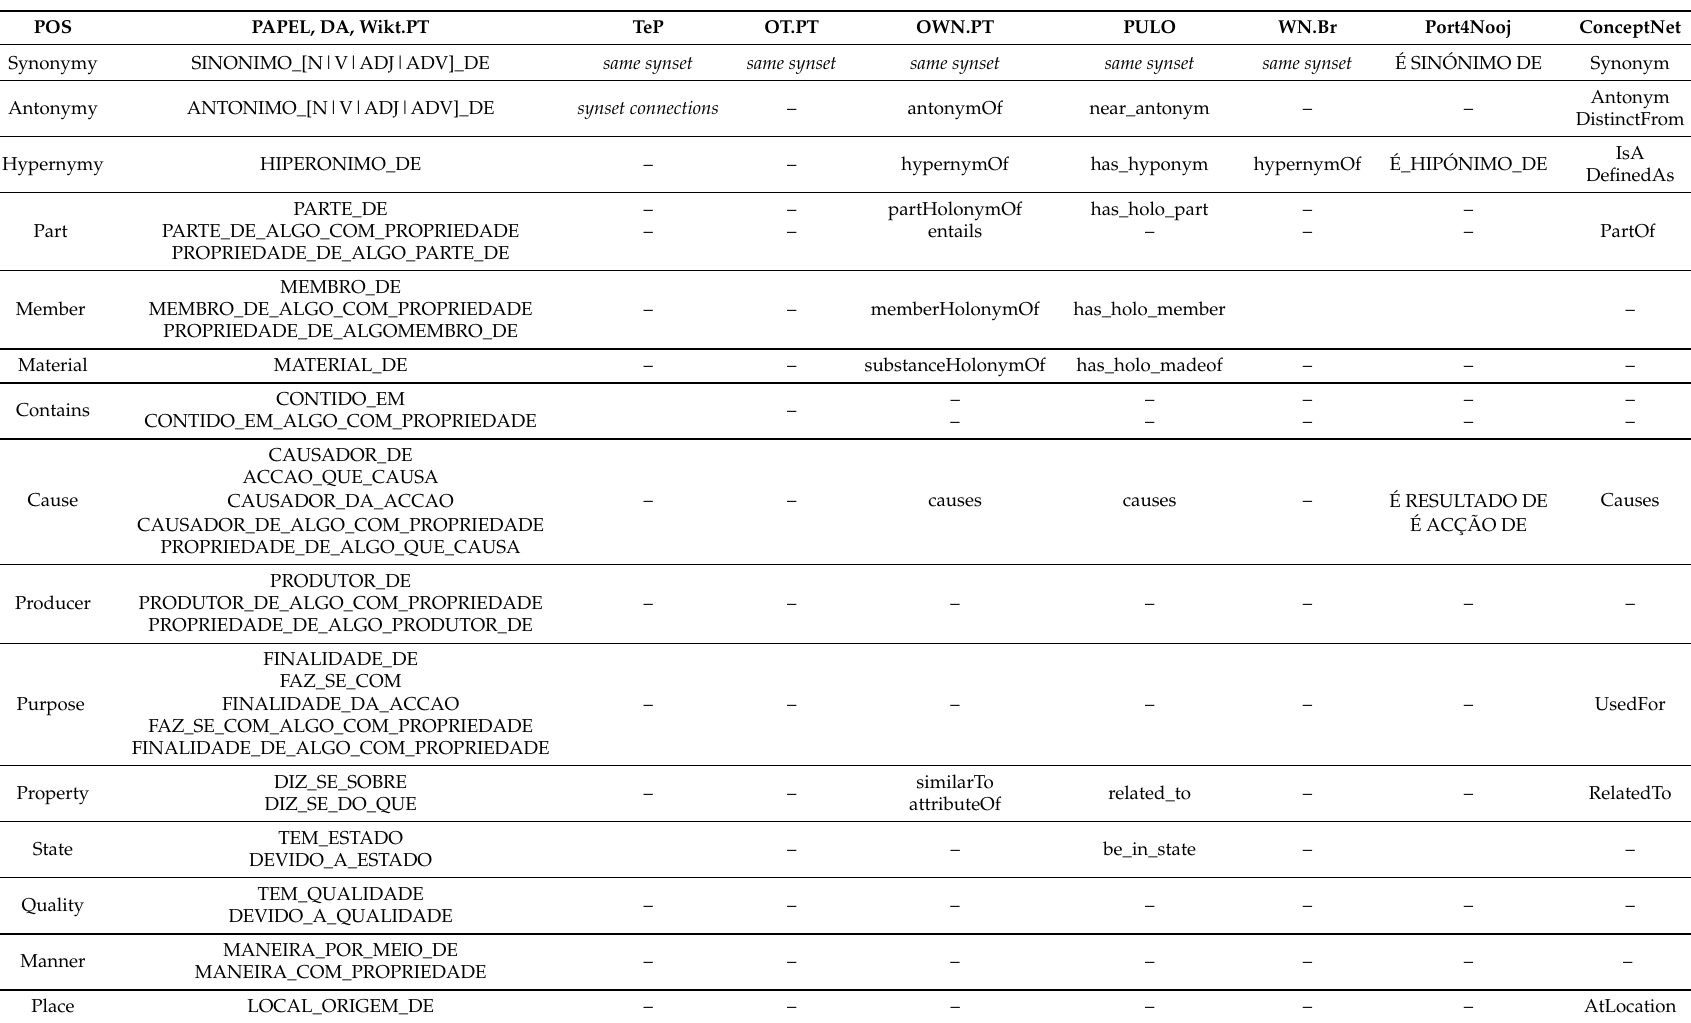
Table 1. Conversion of relations in different